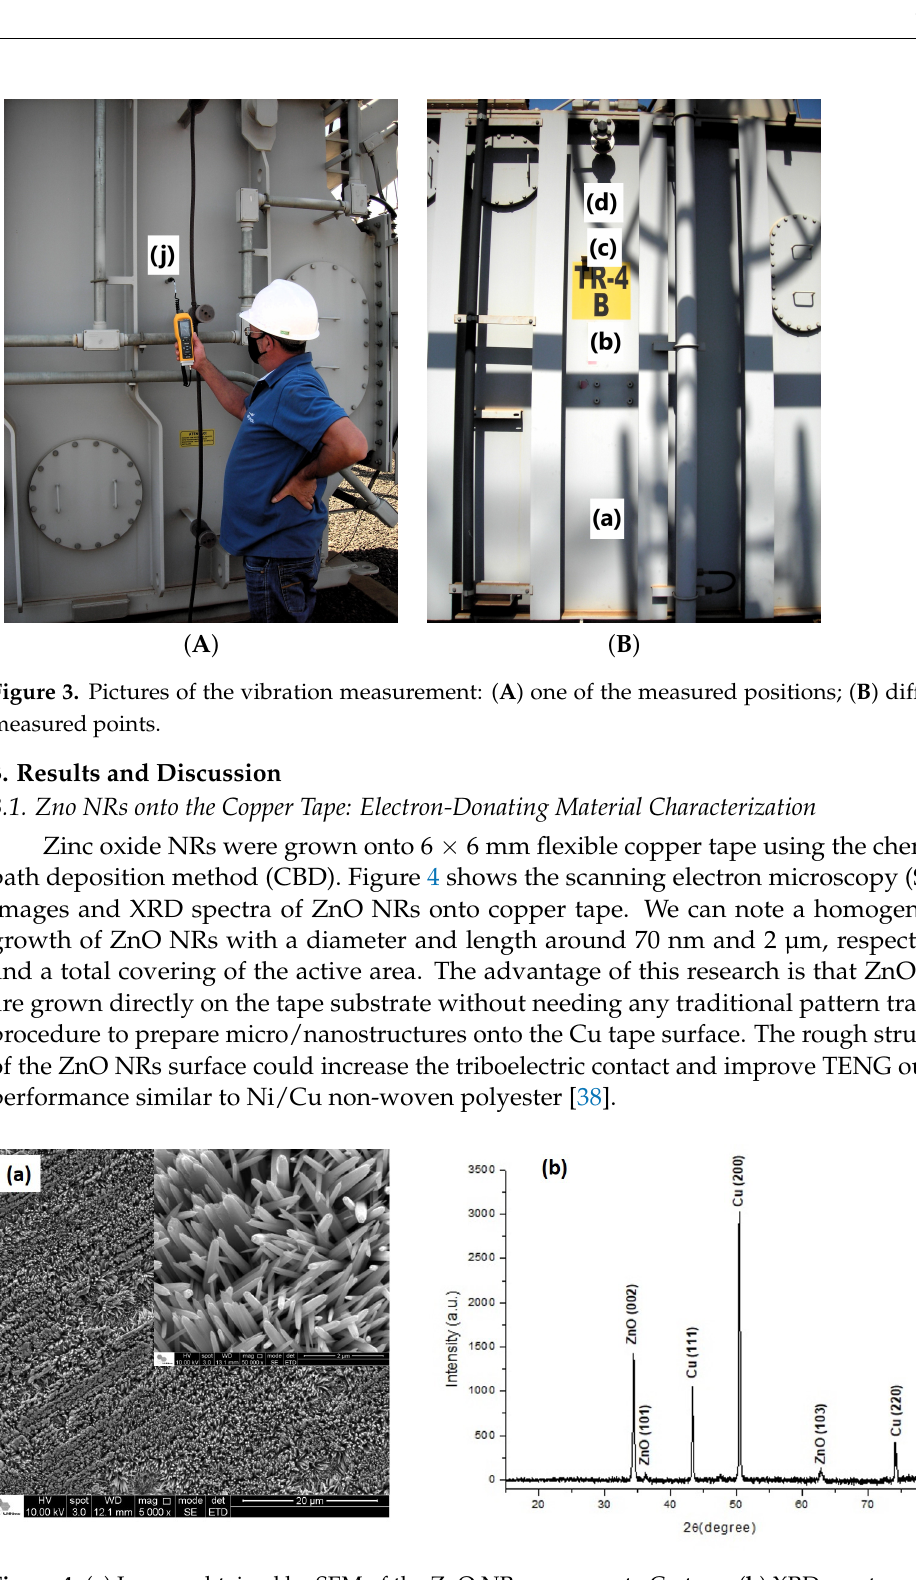
Figure 4. ( a ) Images obtained by SEM of the ZnO NRs grown onto Cu tape; ( b ) XRD spectra of ZnO NRs synthesized onto flexible copper